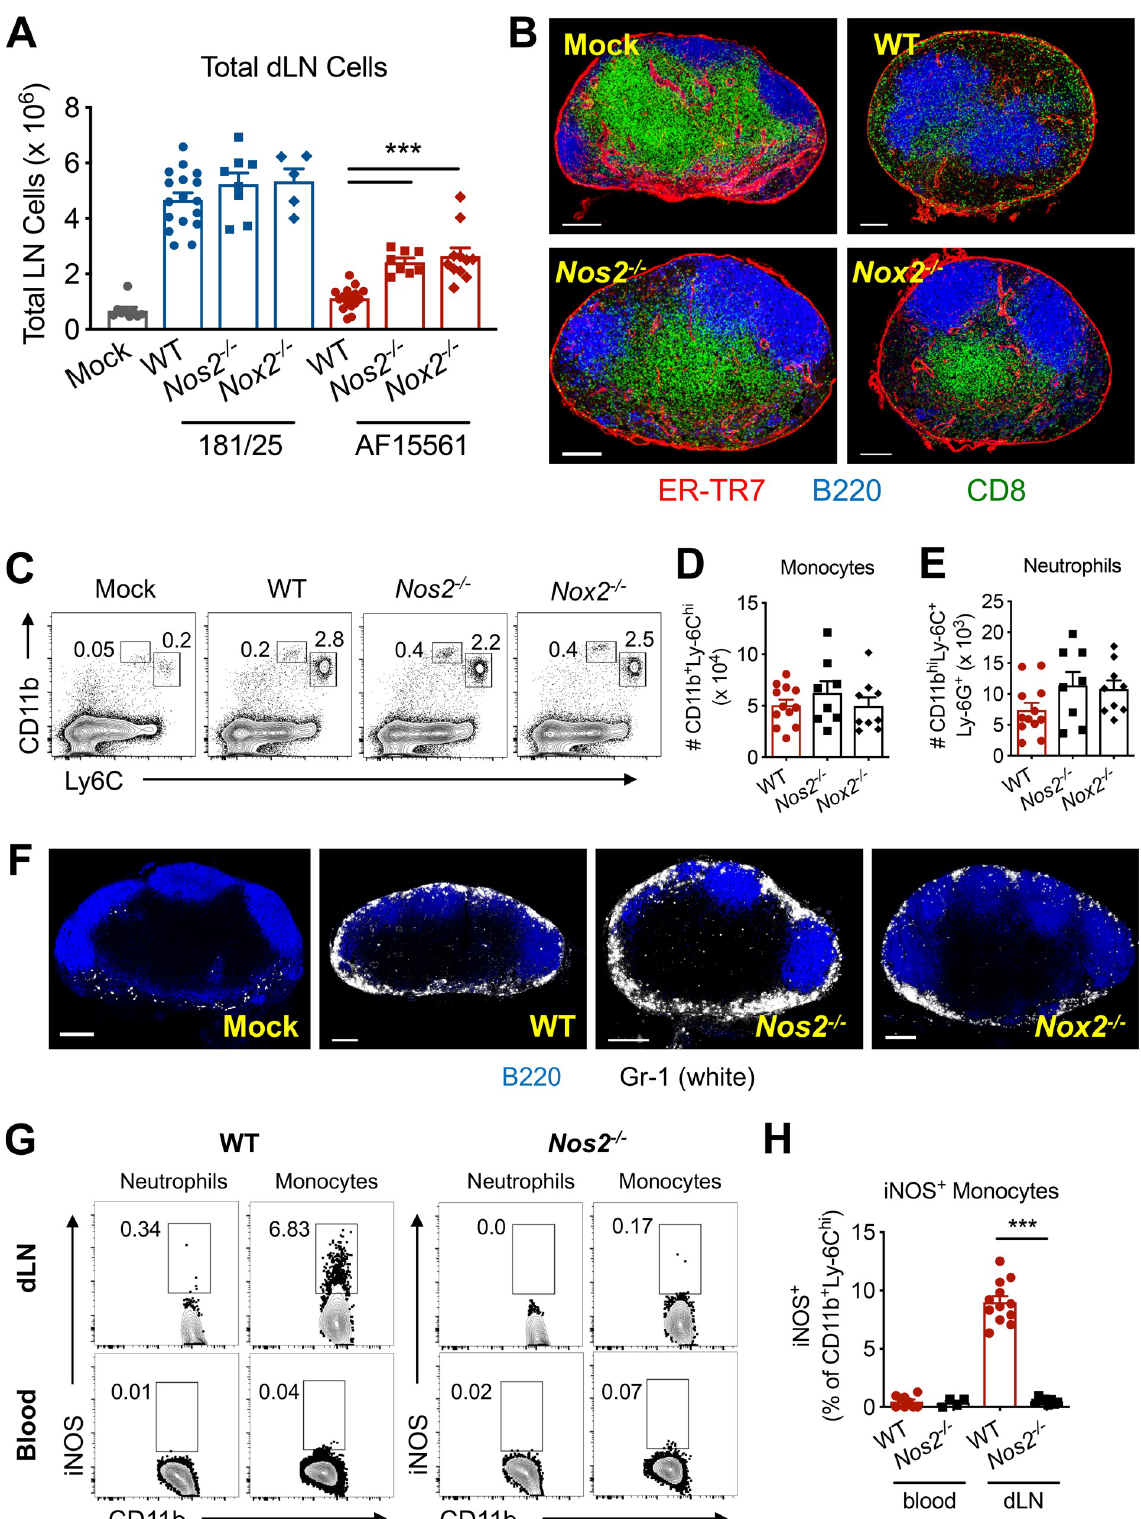
Fig 6. Nos2 and Nox2 contribute to disrupted dLN architecture and lymphocyte depletion. WT, Nos2 -/- , or Nox2 -/- ( gp91phox -/- ) mice were inoculated with PBS or 10 3 PFU of CHIKV AF15561 in the left footpad. ( A ) At 5 dpi, total cells in the dLN were enumerated. Data are